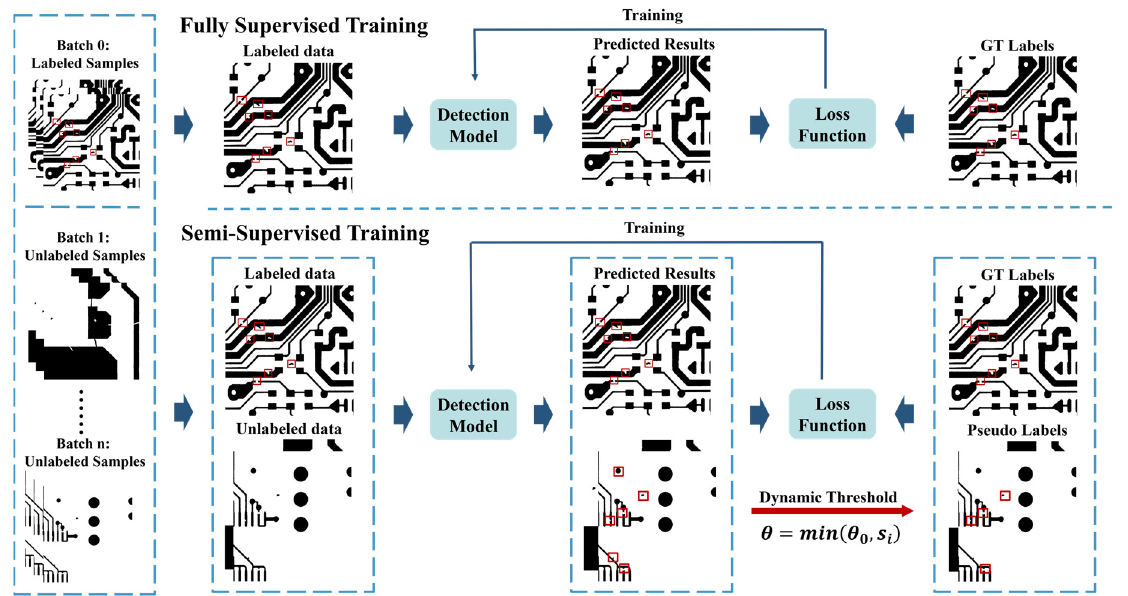
Figure 6. Training process of proposed BA-SSL framework.